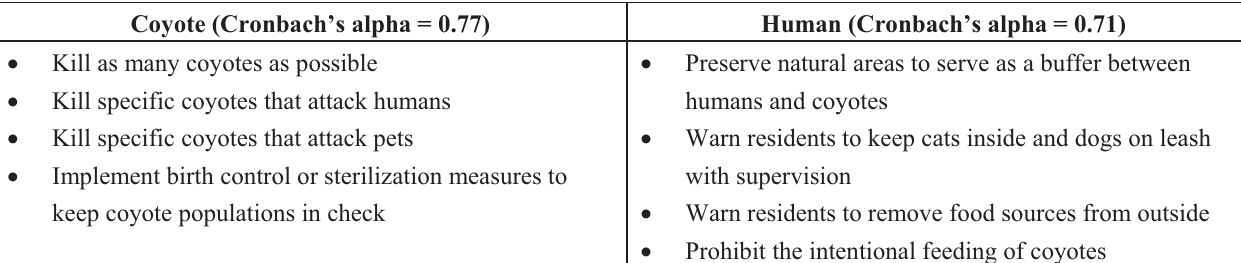
Table 14. Wildlife Management Indices.